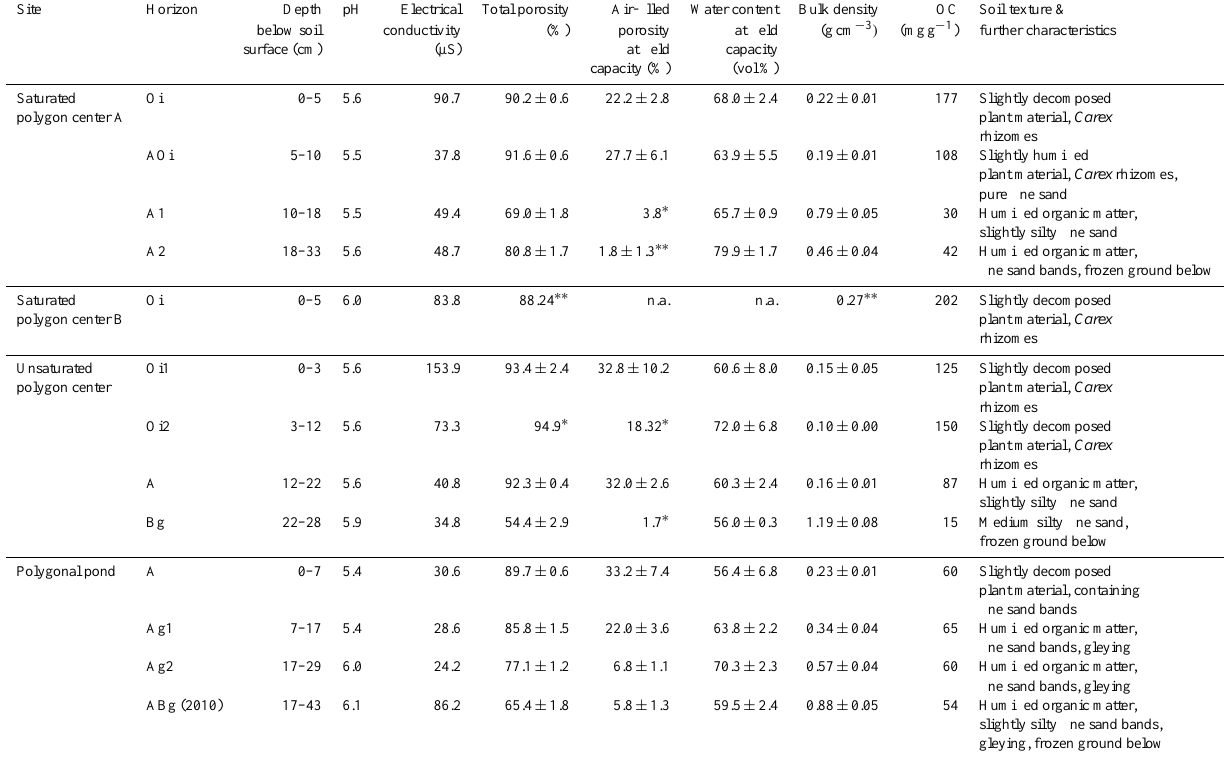
Table 1. Selected physical soil properties. Horizon designation according to US Soil Taxonomy (USDA, 2010). Site Horizon